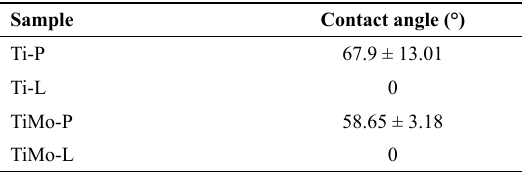
Table 1. Contact angle measurements on Ti and Ti-Mo alloy, polished (P) or modified by laser beam irradiation (L).